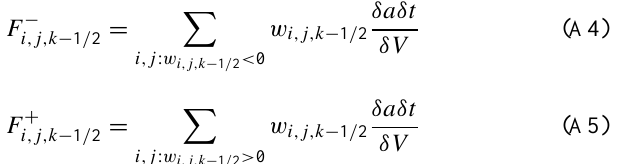
Fig. A1. Passive tracer concentration averaged over vertical (a, c) and averaged across the plume (b, d) after 18h. Thin lines in all panels show the model with advection at highest resolution and averaging of chemical concentrations over gridboxes equivalent to the C8 coarsening case. The thick lines represent the concentrations of the coarsened advection (C8) with two-way exchange turned on (c, d) and advection without the two-way exchange (a,b). Contour intervals are 10ppb and contour lines decrease away from the source (black dot).